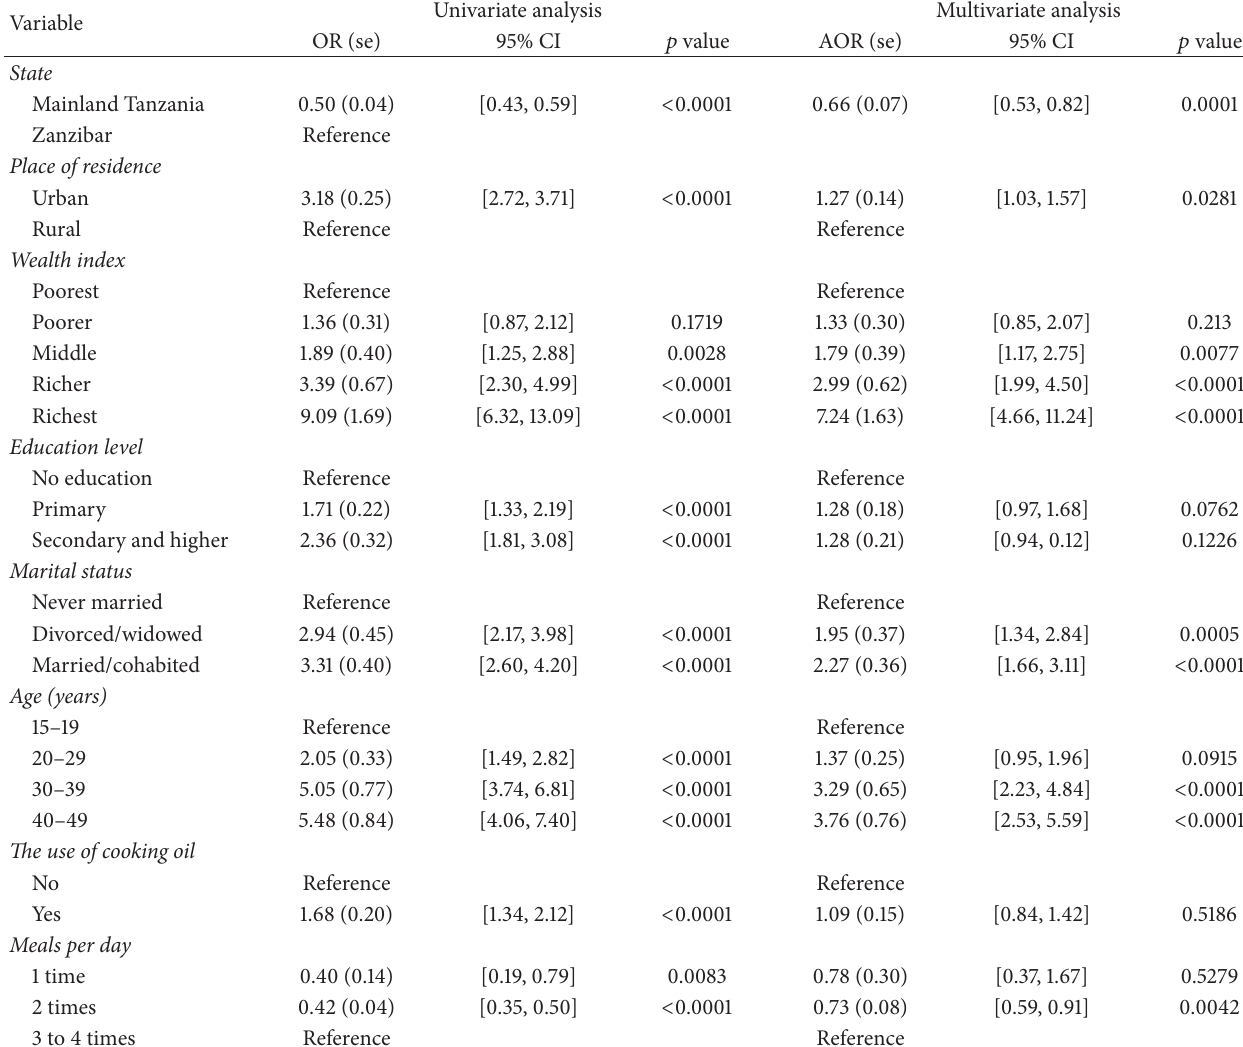
Table 5: Crude and adjusted odds ratios of obesity among nonpregnant Tanzanian